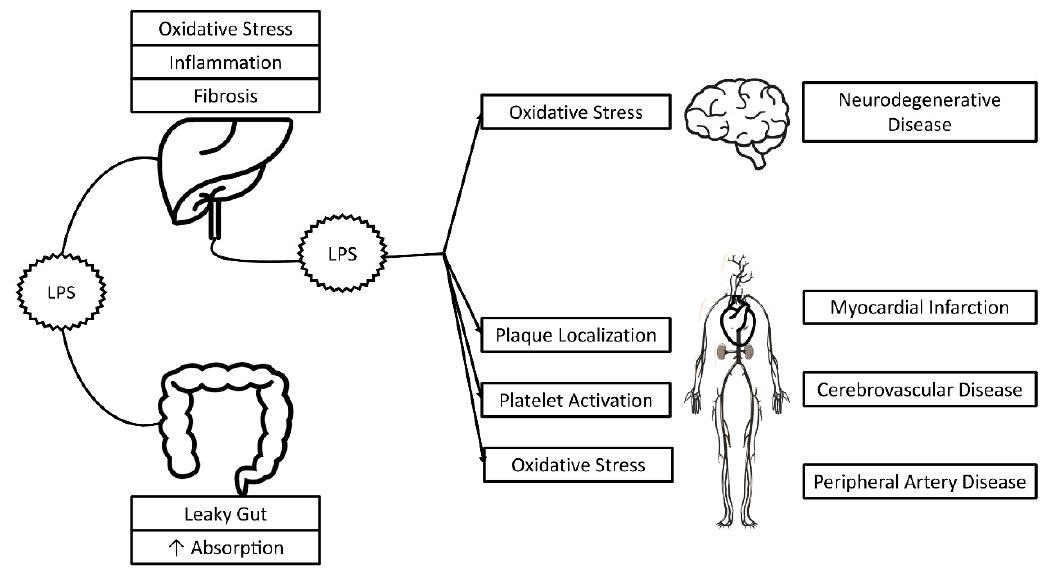
Figure 2. Possible e ff ects of LPS in non-alcoholic fatty liver disease and non-hepatic